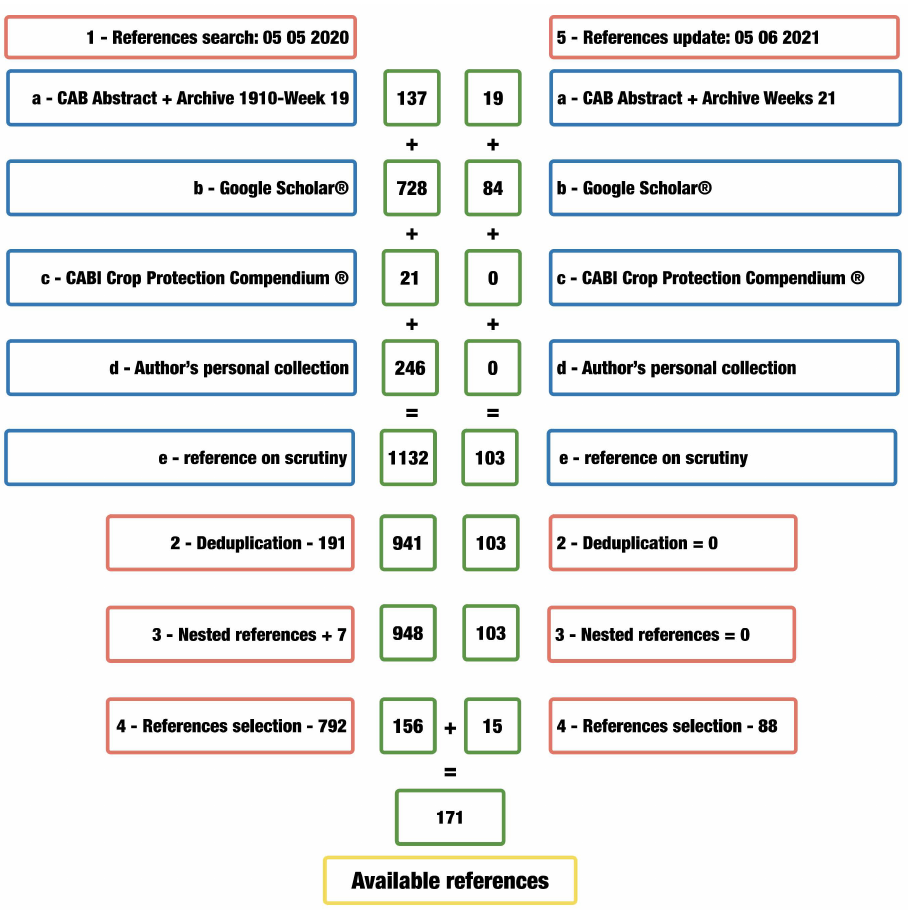
Figure 1. The process adopted to select LAB references analysis, used in this